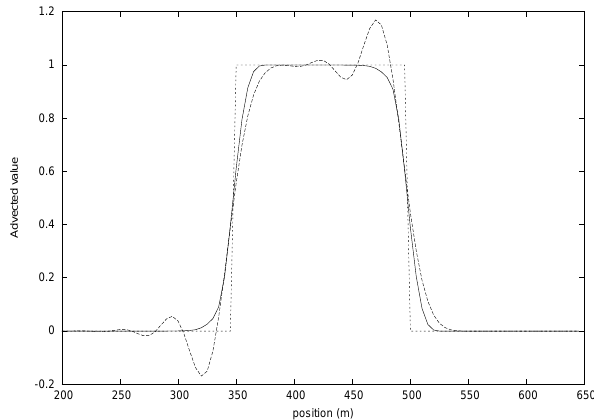
Fig. 1. Advection of a top hat function through 200m using flux- limiting advection (solid line) and the Klemp-Wilhelmshon scheme (long dashes). The short-dashed line shows the exact solution. Grid spacing was 5m and velocity was 1ms − 1